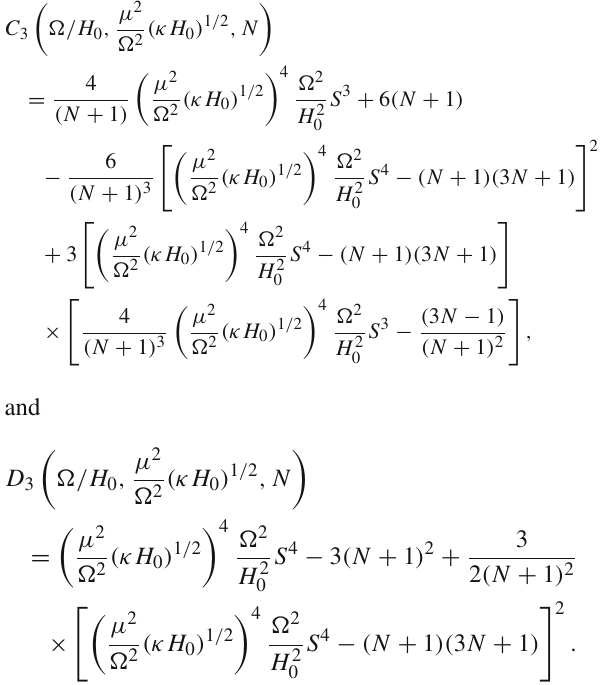
(κ H ) 1 / 2 (cid:2) 110 . 9 with N = 0 2